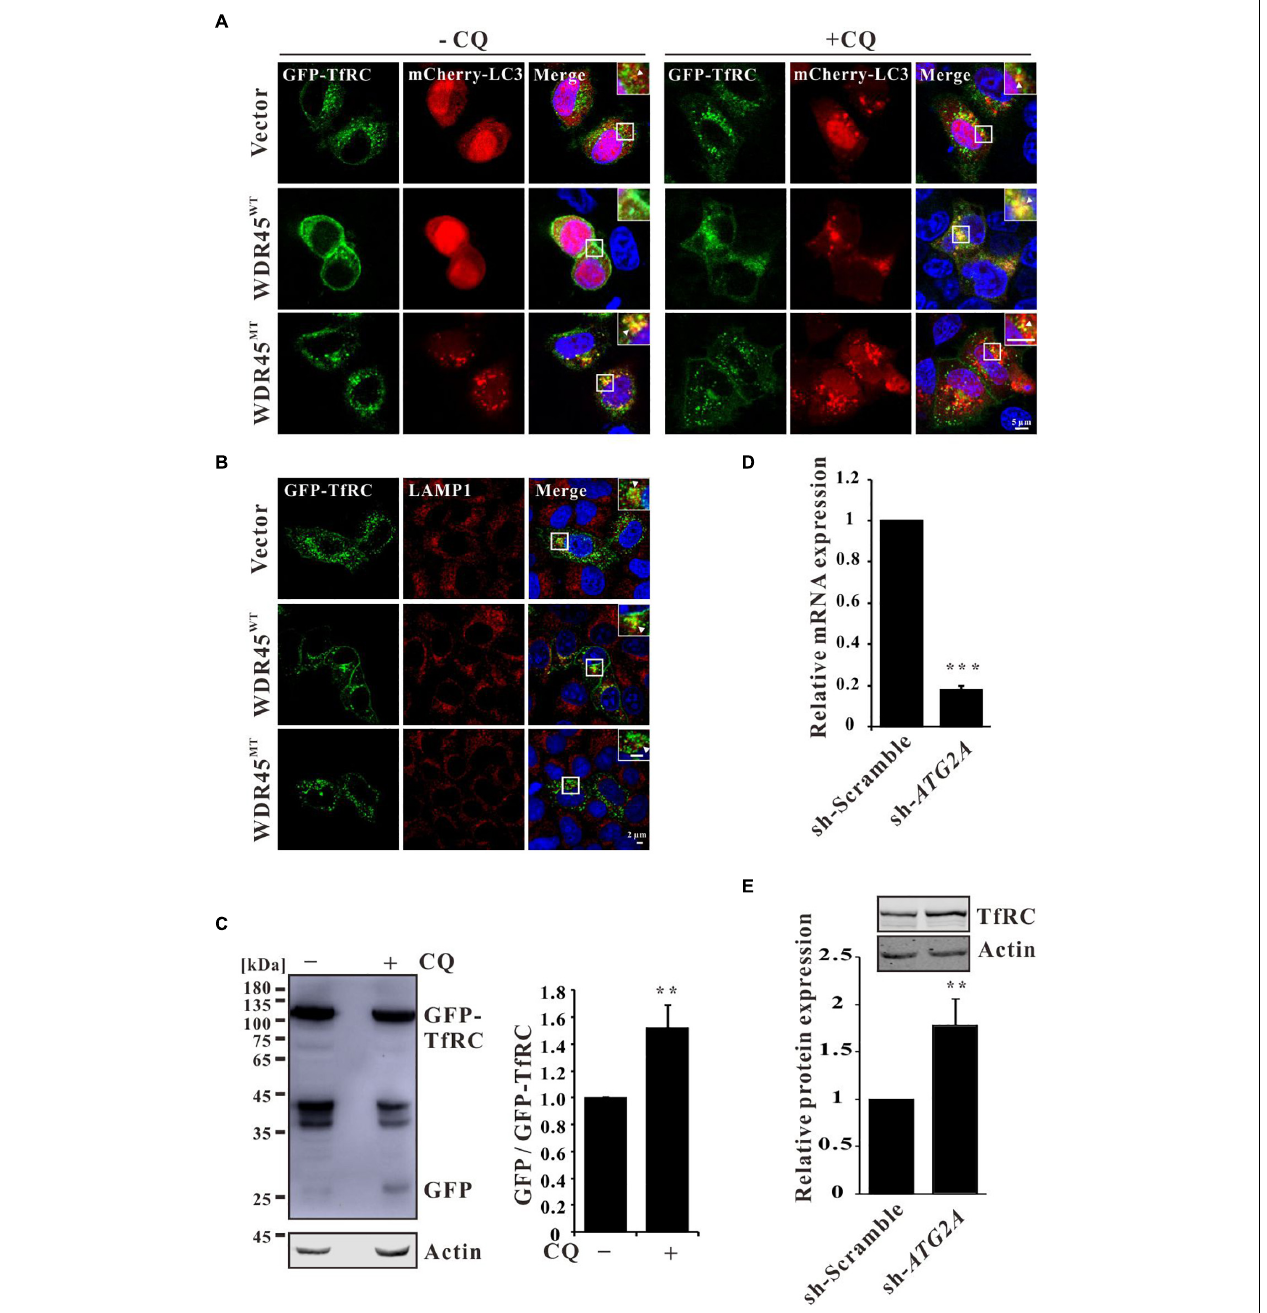
FIGURE 2 | Transferrin receptor (TfRC) was degraded via autophagy. (A) GFP-TfRC co-localized with autophagosomal marker mCherry-LC3. GFP-TfRC and mCherry-LC3 were coexpressed in HeLa cells and treated with 100 µ M chloroquine (CQ) for 8 h, and then the cells were fixed and detected using a confocal microscope. (B) GFP-TfRC co-localized with lysosomal marker LAMP1. GFP-TfRC was expressed in HeLa cells, and then the cells were fixed and stained with the anti-LAMP1 antibody. (C) Proteolytic cleavage assay was performed to detect GFP moiety. GFP-TfRC was expressed in HEK293T cells and then the cells were treated with 10 µ M CQ for 24 h, lysed, and detected by Western blotting using a GFP-specific antibody. (D) qPCR analysis of ATG2A . (E) TfRC was accumulated after the knockdown of ATG2A . ** p < 0.01 and *** p <